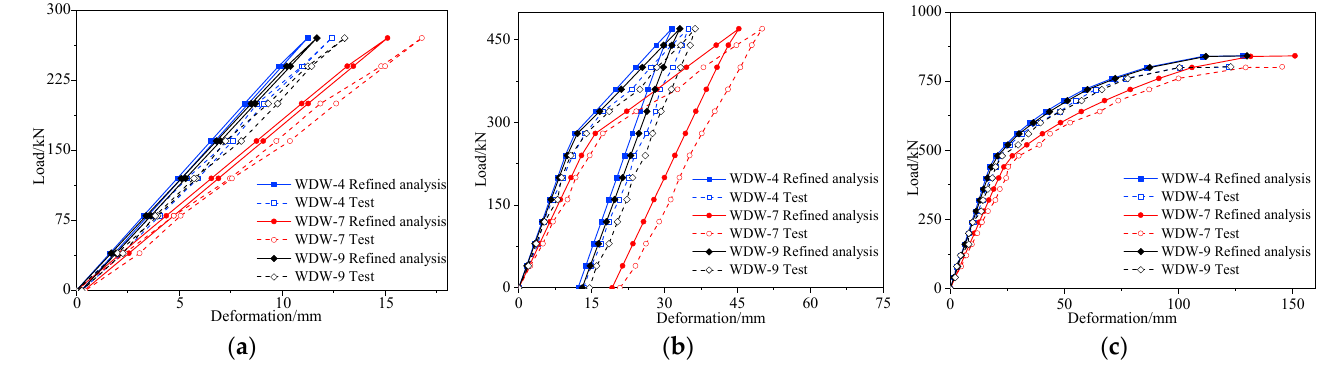
Figure 18. Deformation vs. load of the repaired #3-2 girder strengthened by steel plates. ( a ) Elastic stage; ( b ) Working stage with cracks; ( c ) Failure stage.